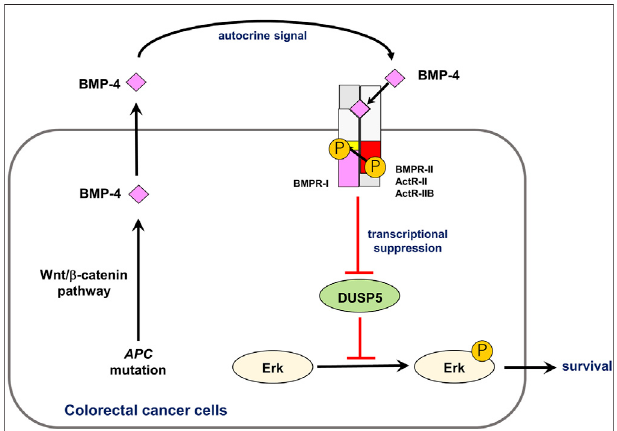
FIGURE 2 | Role of autocrine BMP-4 signaling in CRC. Aberrant activation of the Wnt/ β -catenin pathway induces expression of BMP4 mRNA, activating endogenous BMP signaling. This endogenous signaling promotes phosphorylation of Erk MAP kinase via DUSP5 suppression, which results in survival of CRC cells. Modi fi ed from Yokoyama et al.